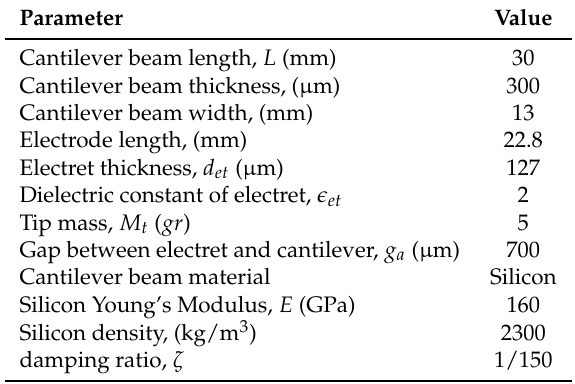
Table 1. Dimensions, specifications, and properties of the harvester